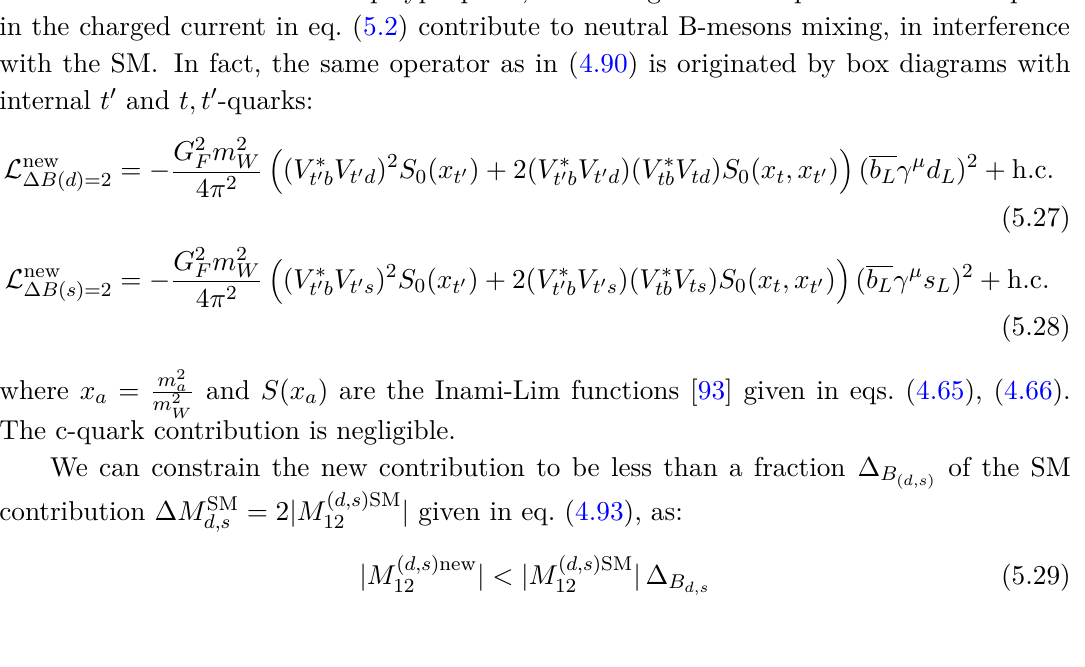
corresponding to an equivalent scale of the new operator Λ